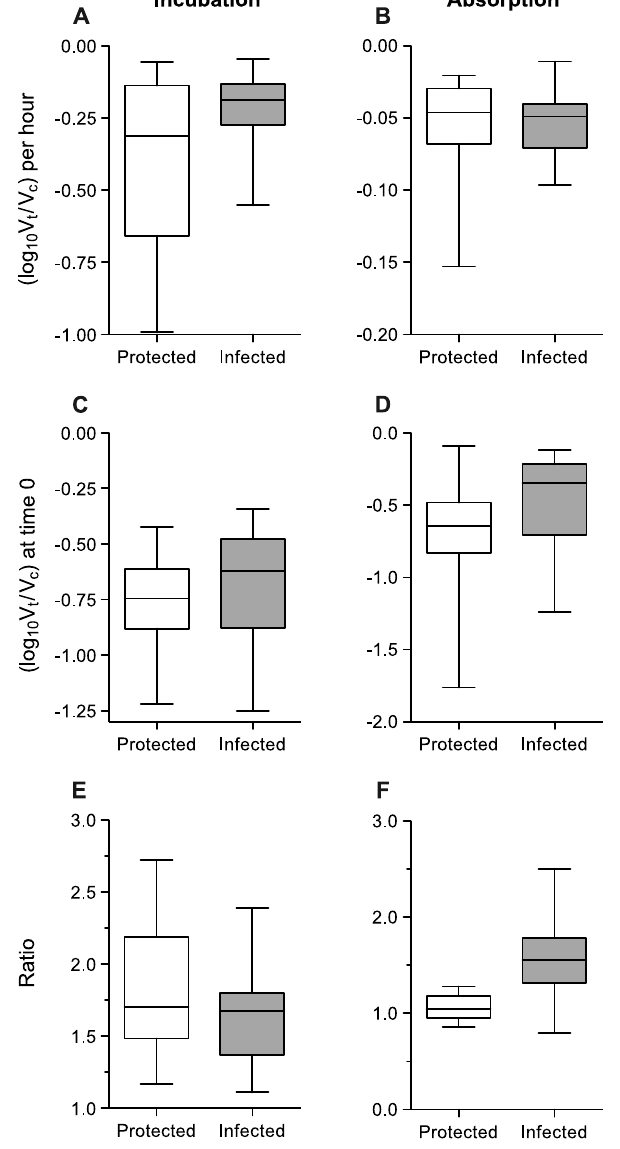
Figure 4. Comparison of serum neutralization functional properties between protected and infected immunized rhesus macaques. Data are summarized in box and whisker plots of the gradients of regression lines (neutralization rates: log 10 (V t /V c ) per hour) and the intercepts (log 10 (V t /V c ) at time 0) with a 1 in 20 dilution of serum. Also, the ratios of neutralization rates with different serum dilutions (expected ratio=2.5) are displayed. The medians of protected (n=13; open boxes) and infected (n=22; striated boxes) rhesus macaques are compared by the Mann-Whitney non-parametric two sample test. Neutralization rates during A , incubation phase (p=0.0788) and B , absorption phase (p=0.7457) of neutralization assay; intercepts during C , incubation (p=0.1888) and D , absorption (p=0.1125) phase of assay; E , incubation ratios (p=0.3748) and F , absorption ratios (p=0.0004).